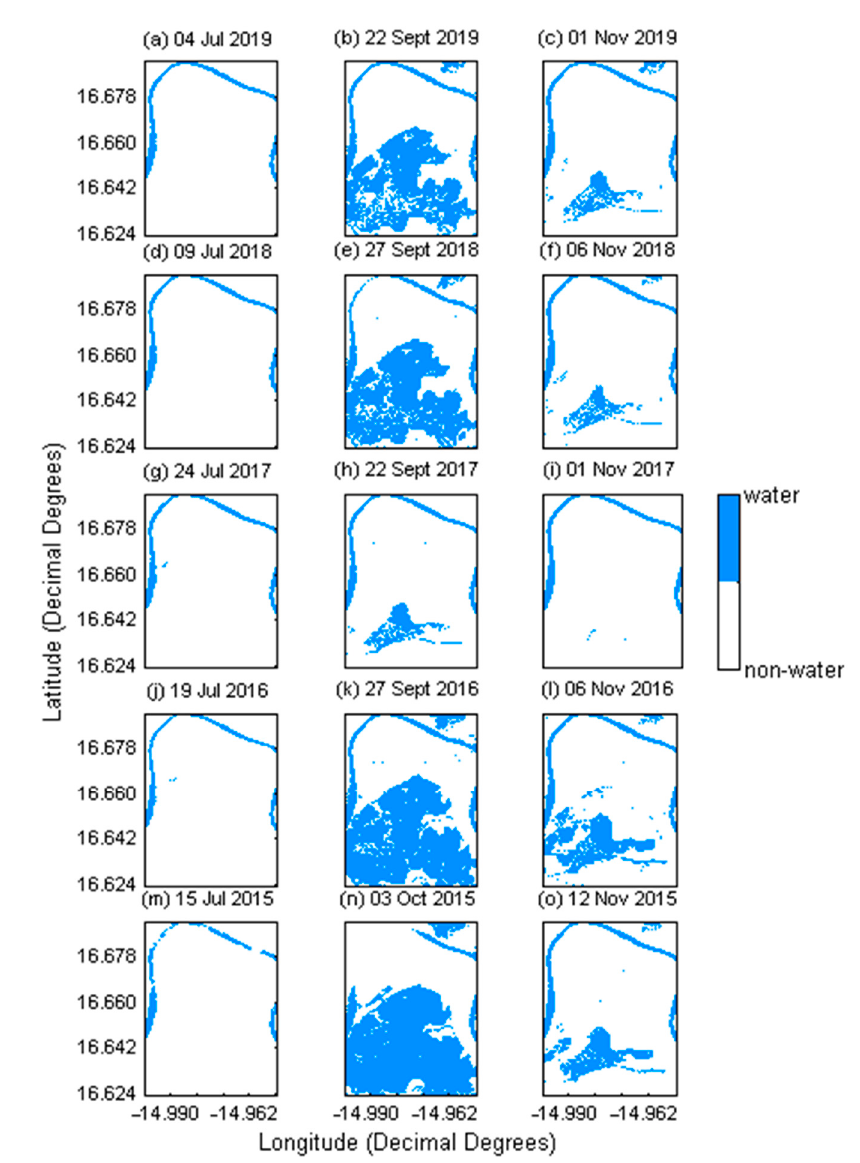
Figure 9. Flooding of the Podor basin: (water and non-water (2015–2019)). ( a – o ): left images show the period just before the flood, images in the middle are close to the maximum flood while images on right are at the end of the flood receding.